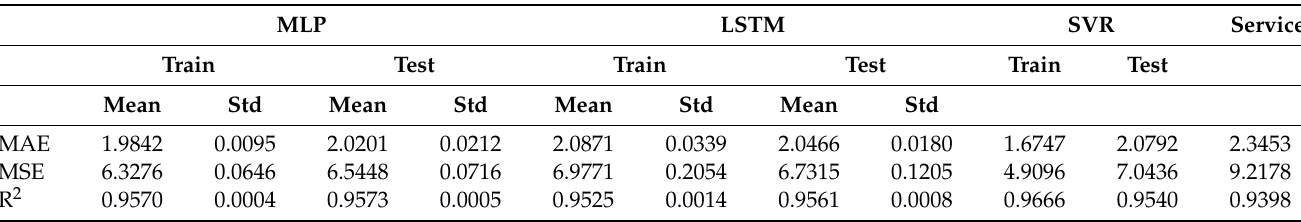
Table 9. Comparison of the effectiveness of the MLP model, two other models, and the weather service in forecasting the maximum